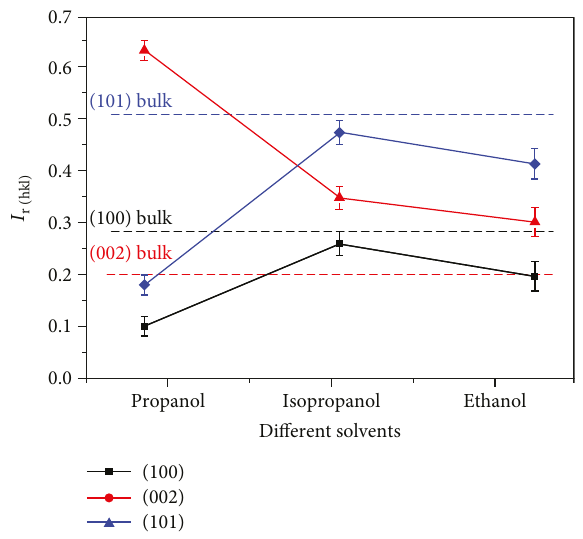
Figure 2: Relative intensity ratio of ZnO fi lms obtained using di ff erent